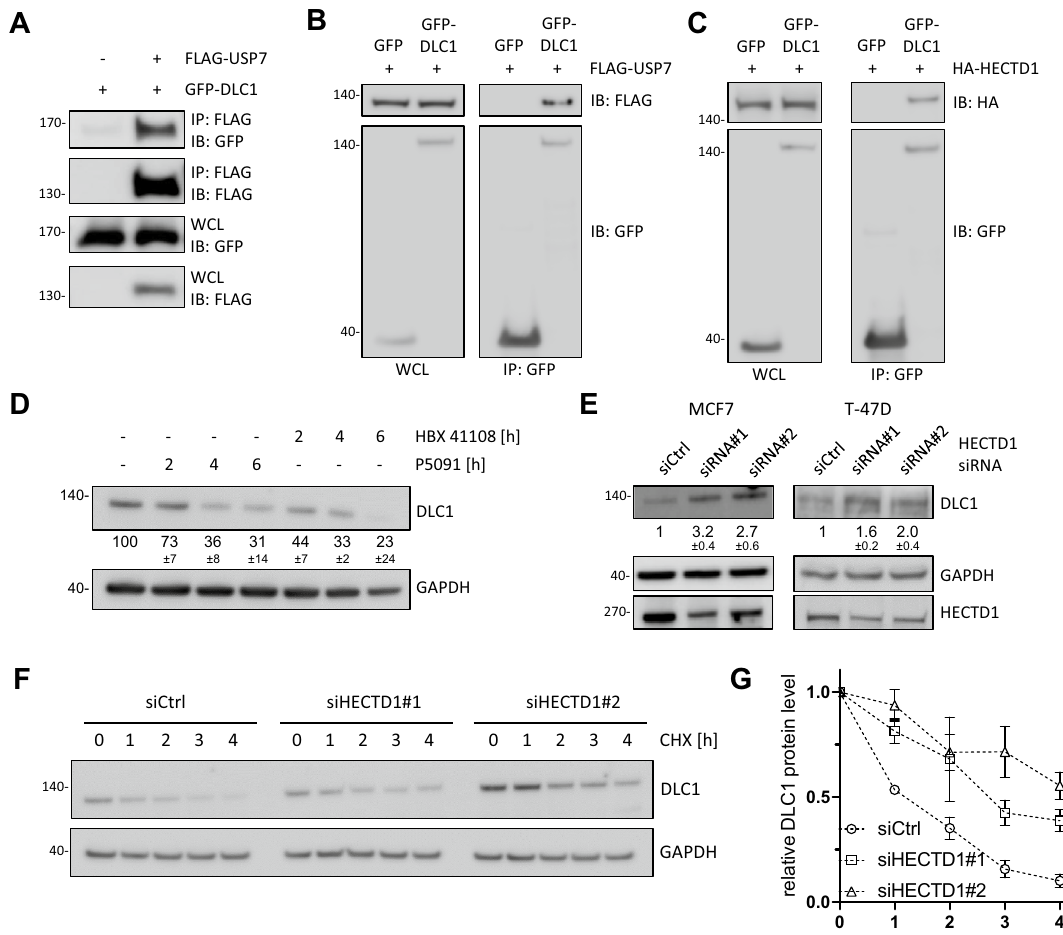
Figure 2. HECTD1 and USP7 are novel regulators of DLC1 stability. ( A , B , C ) HEK293T cells were transiently transfected with vectors encoding the indicated constructs or FLAG empty vector (−). ( A ) The next day, cells were lysed and immunoprecipitation with an anti-FLAG antibody was performed. Cell lysates (WCL) and precipitates were analyzed by immunoblotting using the indicated antibodies. Cropped blots showing co-immunoprecipitation signals are derived from blots with different exposure compared to WCL. ( B , C ) The next day, cells were lysed and immunoprecipitation with an anti-GFP-nanobody was performed. Cell lysates (WCL) and precipitates were analyzed by immunoblotting using the indicated antibodies. Cropped blots showing co-immunoprecipitation signals are derived from blots with different exposure compared to WCL. ( D ) MCF7 cells were treated with P5091 (20 µM) or HBX 41108 (10 µM) as indicated and lysates were analyzed by immunoblotting with the indicated antibodies. The control sample was treated with DMSO for 6 h. Western blots from three independent experiments were analyzed with ImageJ, the fold change in DLC1 expression was determined by normalizing the DLC1/GAPDH ratio to that of control sample and is presented as mean ± s.d. ( E ) Cells were transfected with control siRNA or two independent siRNAs targeting HECTD1. 72 h post transfection cells were lysed and lysates were analyzed by immunoblotting with the indicated antibodies. Cropped blots shown from different cell lines are derived from separate blots. Western blots from three independent experiments were analyzed with ImageJ, the fold change in DLC1 expression was determined by normalizing the DLC1/GAPDH ratio to that of control sample and is presented as mean ± s.d. ( F ) MCF7 cells were transfected with control siRNA or two siRNAs targeting HECTD1. 72 h post transfection cells were treated with cycloheximide (CHX, 60 µg/ml) as indicated and lysates were analyzed by immunoblotting with the indicated antibodies. ( G ) Quantification of protein levels from ( F ) by ImageJ. n = 4, error bars represent mean ± s.d. ( A , B , C , D , E , F ) Full-length western blots are provided as Supplementary